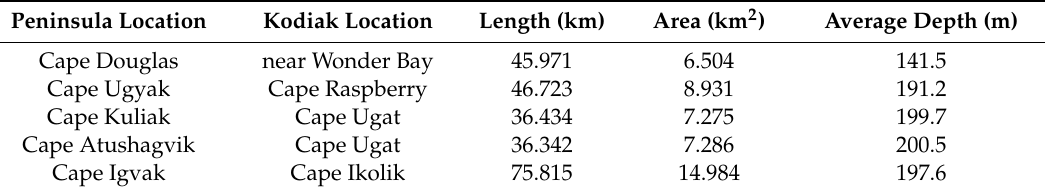
Table 2. Cross-sectional openings in the Shelikof Strait region of the Gulf of Alaska. Peninsula Location Kodiak Location Length (km) Area (km 2 ) Average Depth (m) near Wonder